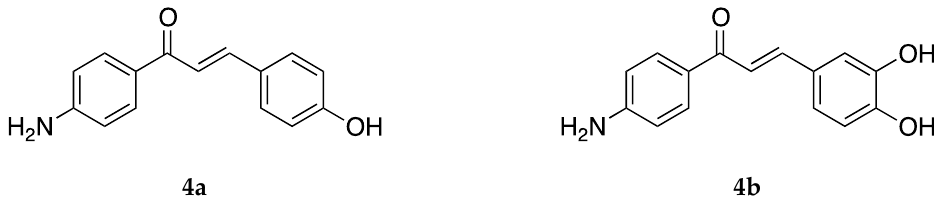
Figure 6. Chemical structures of 4-aminochalcone derivatives with hydroxy substitutions on ring B.